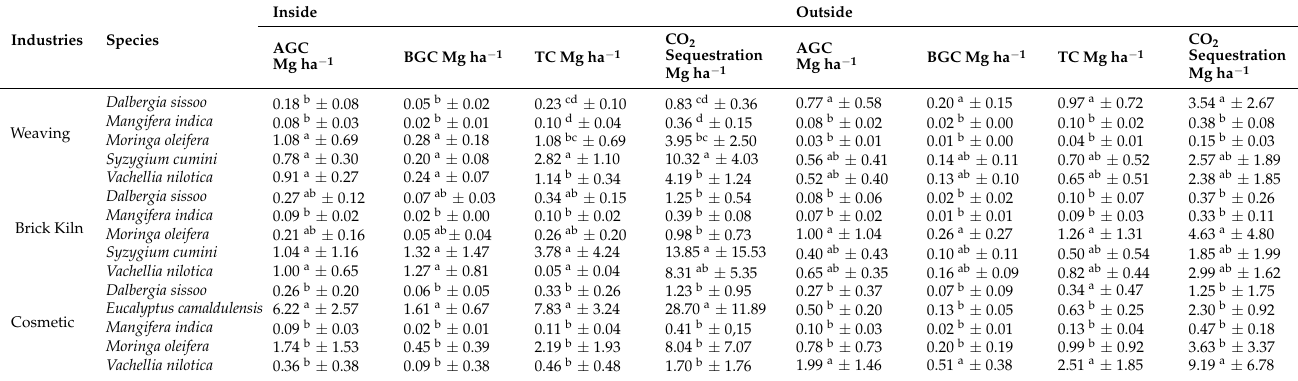
Table 5. Carbon of different tree species present inside and outside the different